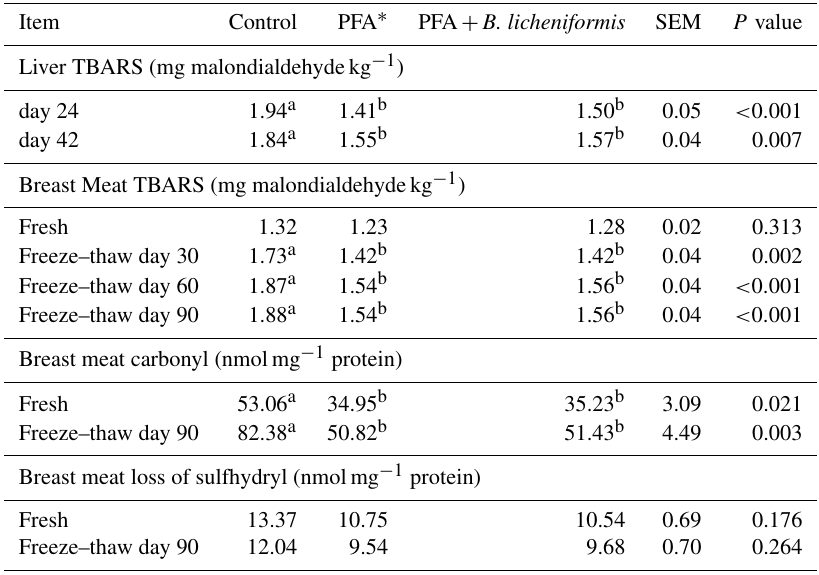
Table 7. Lipid peroxidation of liver, and lipid and protein oxidation of fresh and freeze–thaw breast meat of broiler chickens fed supplemental phytogenic feed additive alone or in combination with Bacillus licheniformis